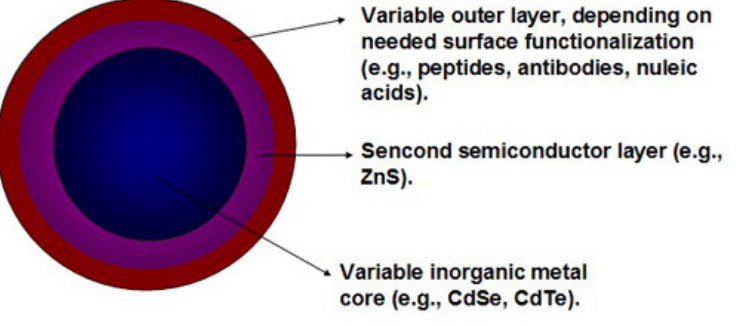
Figure 1. Schematic representation of a quantum dot. QDs are nanocrystals composed of